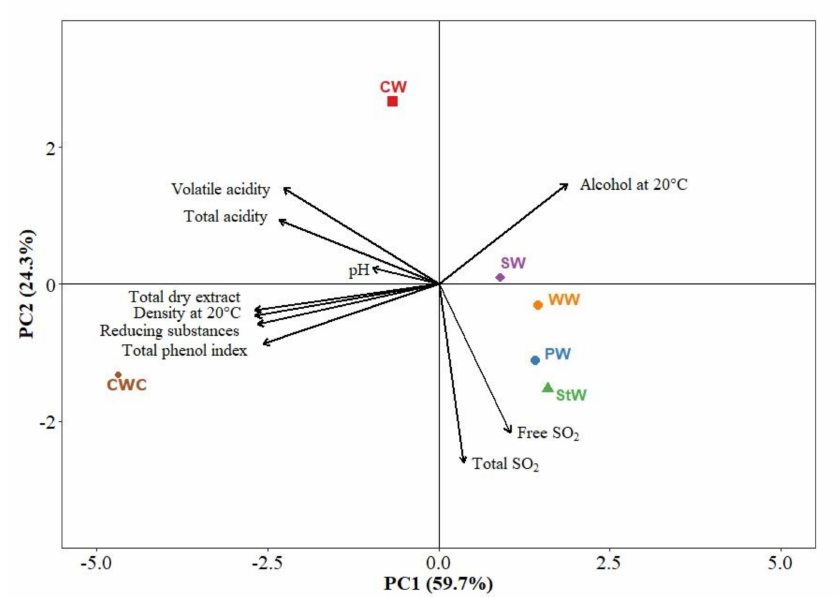
Figure 4. Bi-plot of the Principal Component Analysis (PCA) with the main physico-chemical parameters of wines (sample description in Table 1).